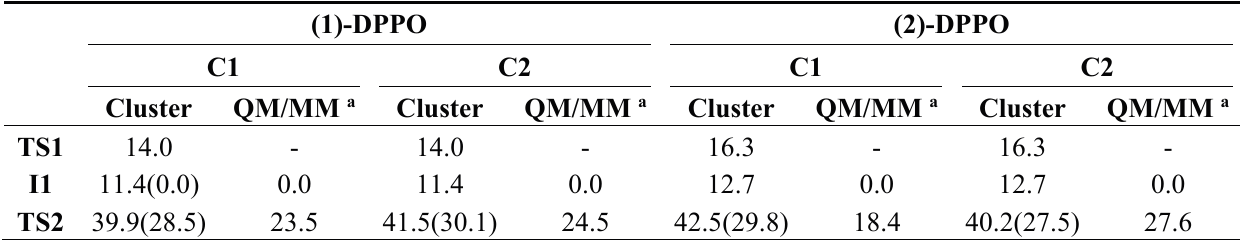
Table 1. Relative potential energies obtained at AM1 level related to reactant complex (RC) for nucleophilic attack of Asp333 to epoxide carbons C1 or C2 in two different orientations of substrate in the active site of sEH. Values in parentheses correspond to relative energies of TS2 to I1. Results are given in kcal·mol − 1